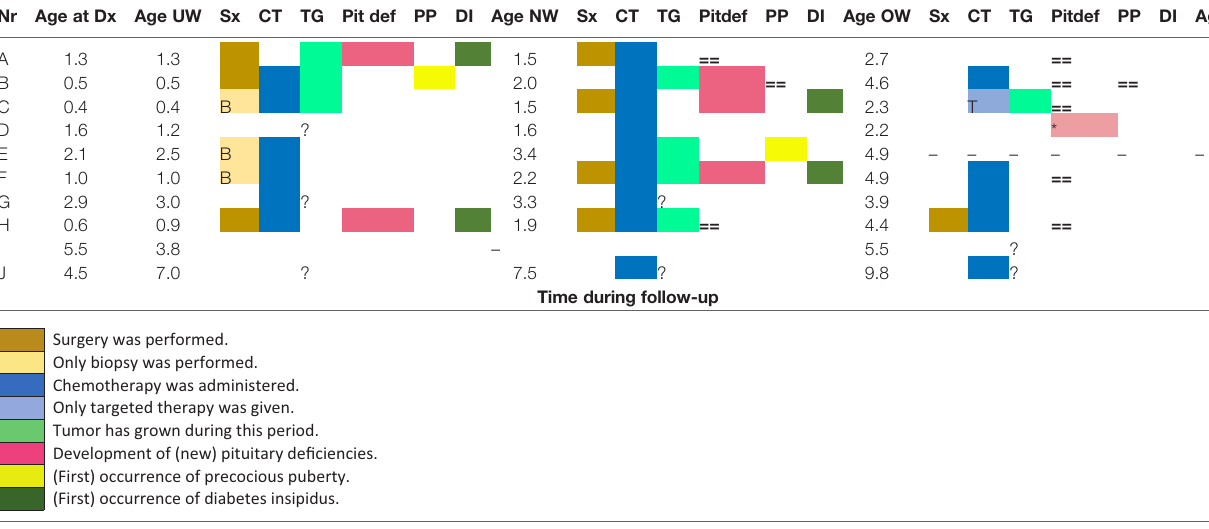
TABLE 3 | Timeline of events, treatment and pituitary de fi ciencies in relation to